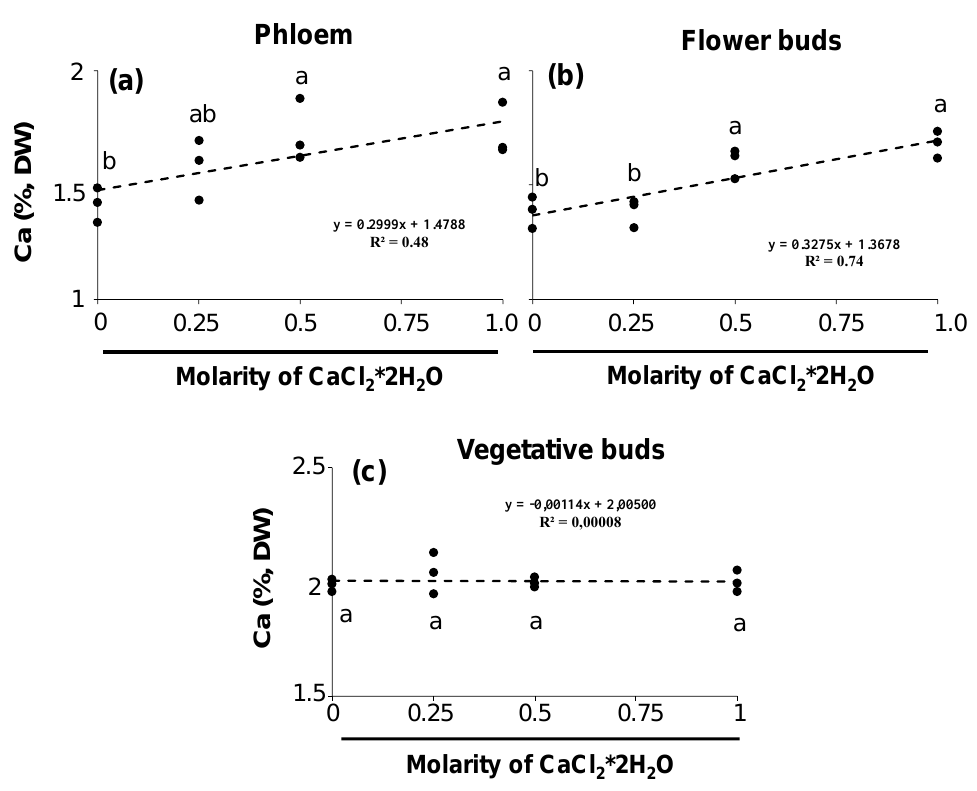
Figure 2. Calcium content from the phloem ( a ), flower ( b ), and vegetative buds ( c ) following 1 week of calcium treatments (0, 0.25, 0.5, and 1M CaCl 2 *2H 2 O). Regression analysis of tissues in response to the different calcium concentration in triplicate per condition. Different letters indicate significant difference based on Duncan’s multiple range test, p ≤ 0.05. Table 1. The effect of different factors in fruit set (40 DAFB) and in on-tree fruit cracking at harvest (81 DAFB).